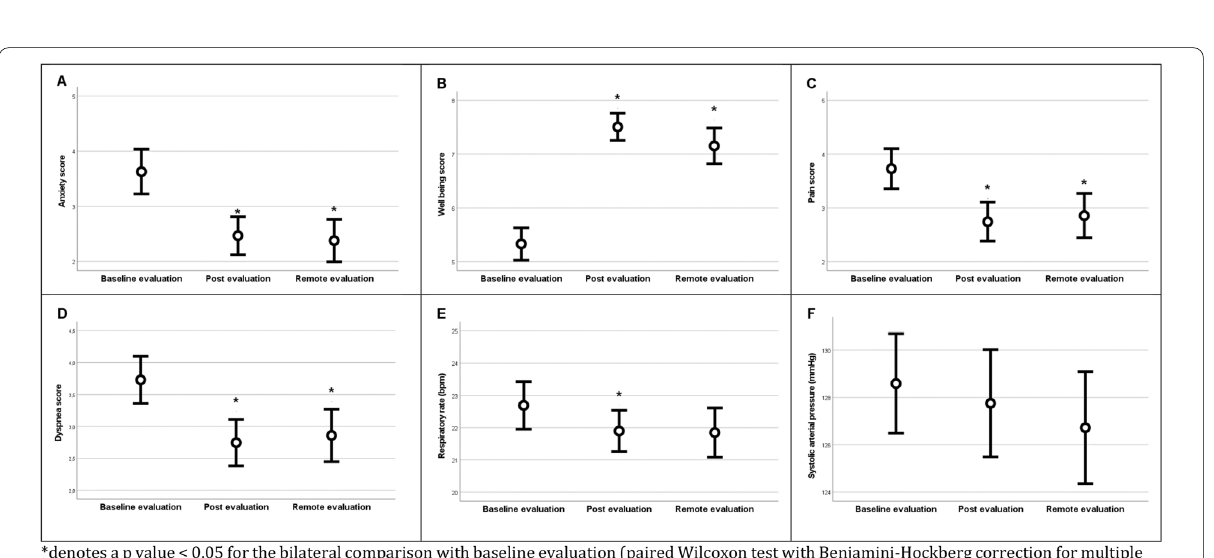
SAP systolic arterial pressure # Friedman test